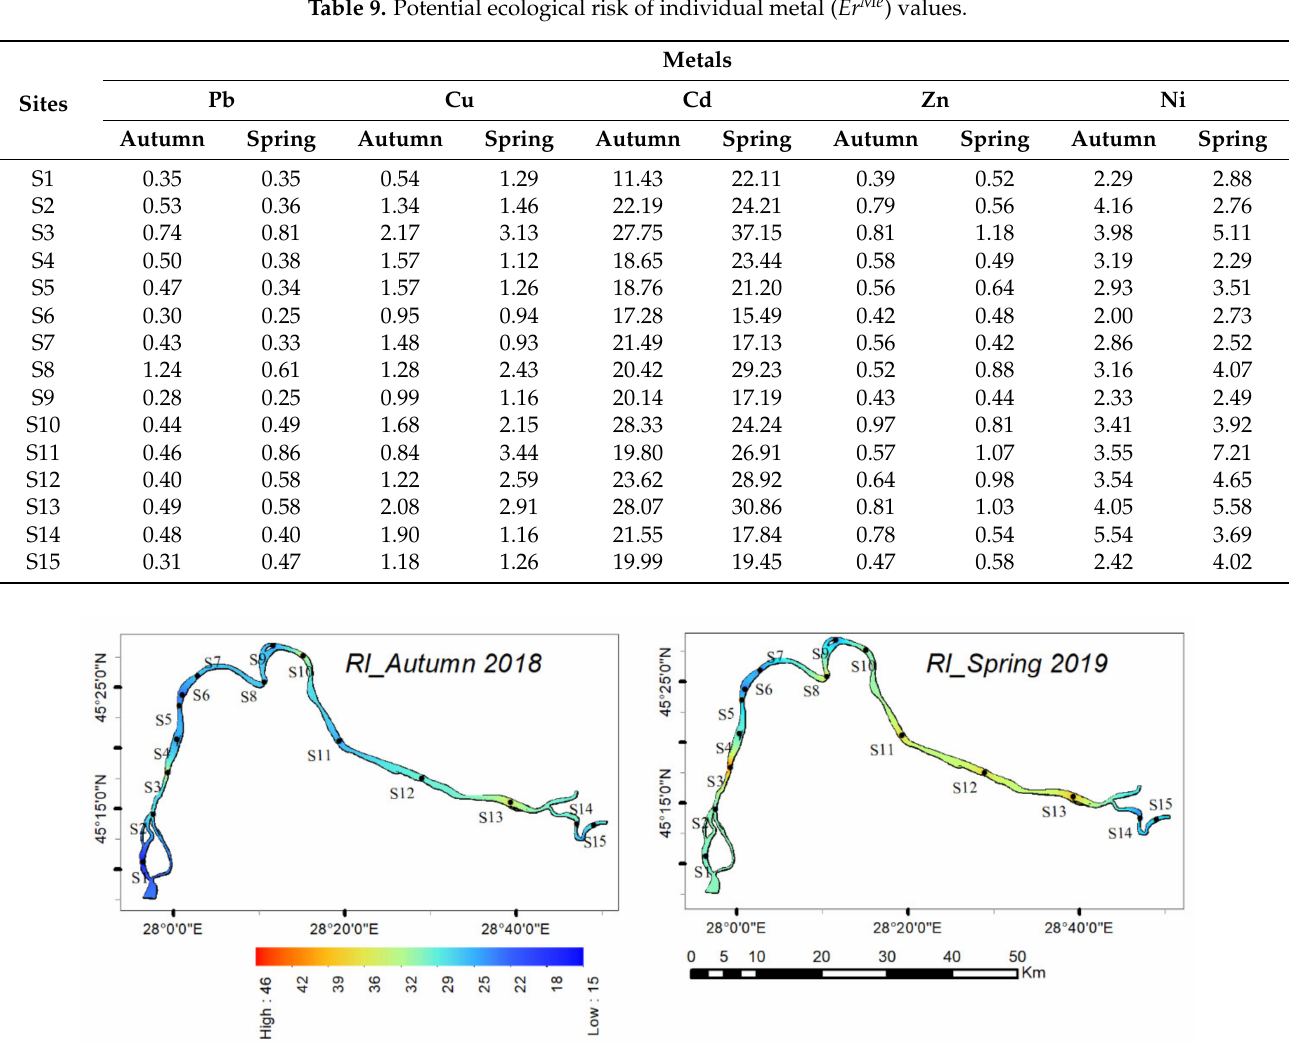
Figure 5. Spatial distribution of the RI in the autumn of 2018 and the spring of